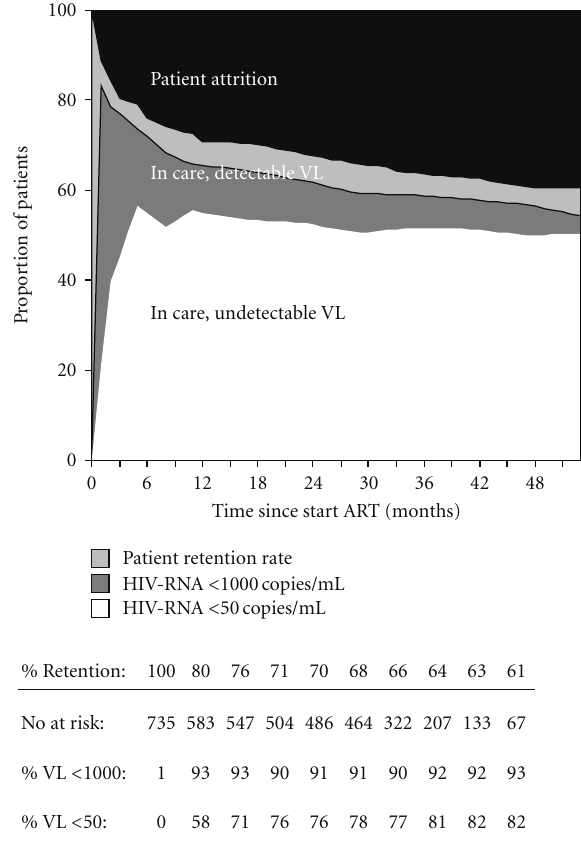
Figure 2: Viral replication during 1st line